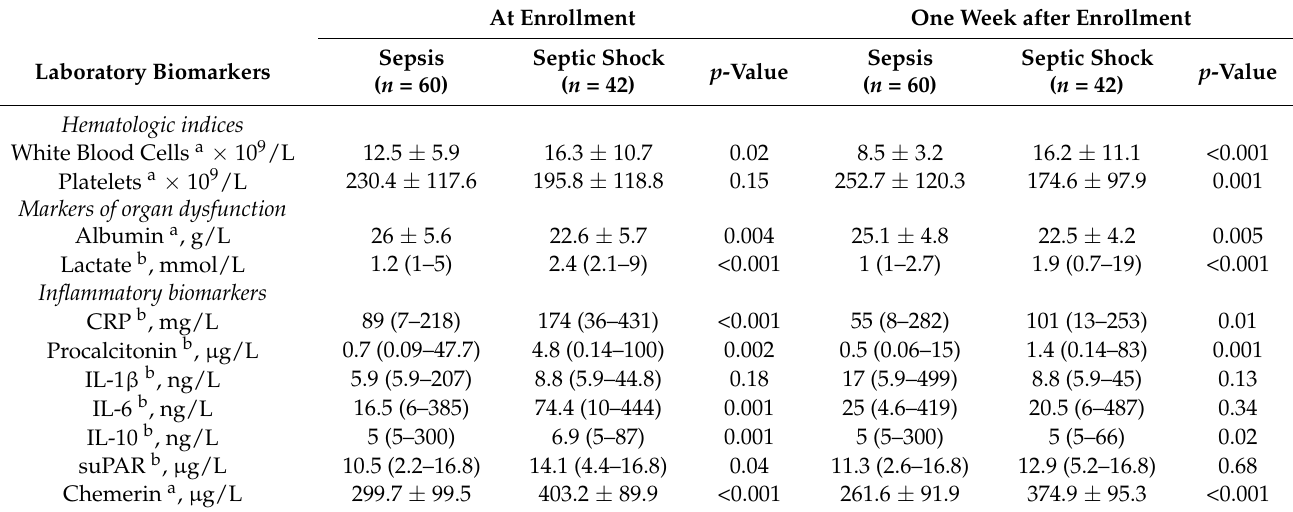
Table 2. Major laboratory biomarkers * of patients with sepsis and septic shock, at baseline and one week after enrollment ( n = 102).